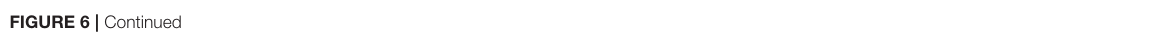
FIGURE 6 | Continued disrupted single cell suspensions were stained using fluorochrome-conjugated antibodies specific for CD4 + , CD8 + , CD11b + , or CD11c + and evaluated by flow cytometry. (A) Live cells were determined according to the size and granularity on the FSC vs. SSC histogram, and different subsets of cells were analyzed gated on live cells. CD11b + or CD11c + cells were measured in the cell population that was negative for CD4 and CD8. The figure is representative of three independent experiments. (B) The percentages of CD4 + , CD8 + , CD11b + , and CD11c + cells in the LNs of control, GP or GP + LPS-RS-treated mice are expressed as mean ± SEM of three independent experiments in flow cytometry ( n = 3 per group). Significance of differences between treatments was analyzed by one-way ANOVA